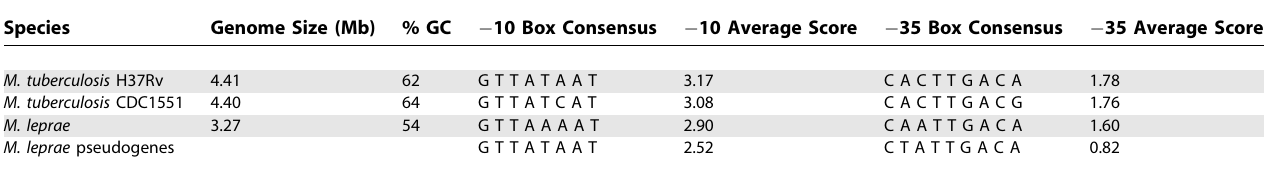
Table 3. (cid:1) 10 and (cid:1) 35 Consensi and Average Scores for the Degrading Genome of M. leprae and Its Close Relative M. tuberculosis Species Genome Size